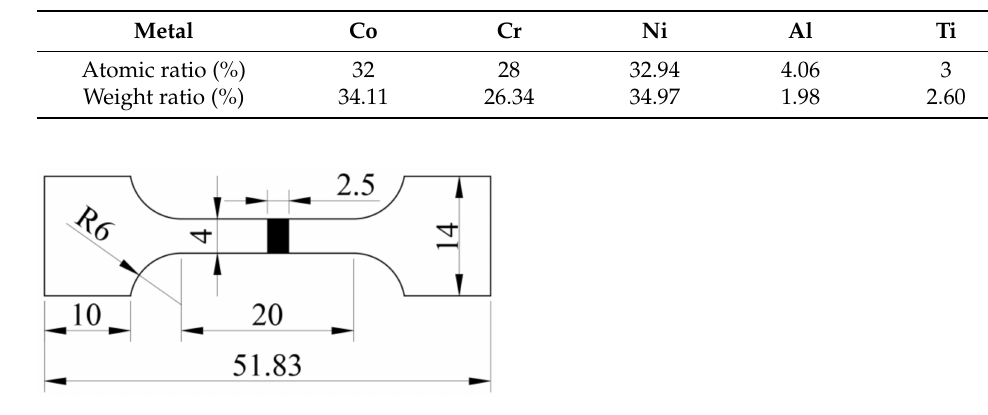
Figure 1. Dimensions of the tensile specimen